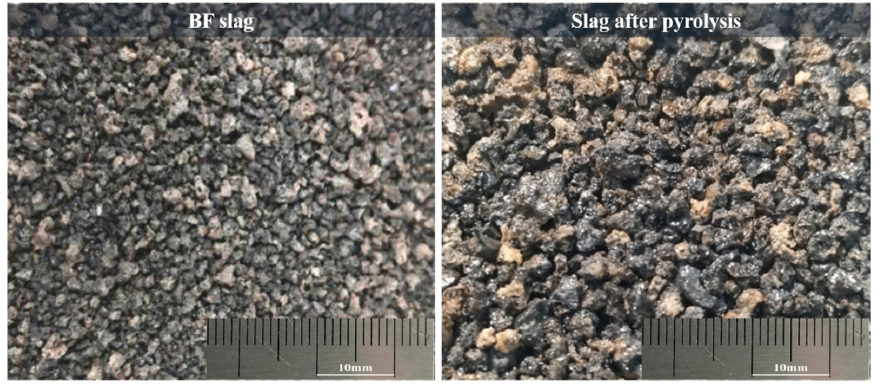
Figure 3. Hemispherical point method.